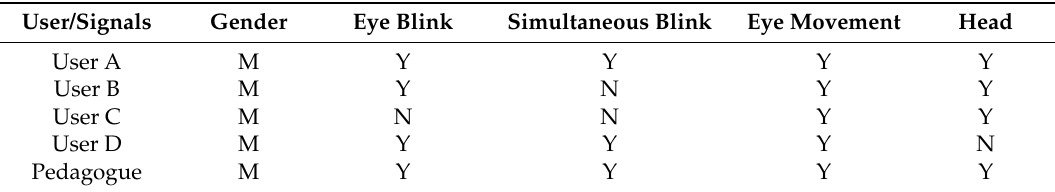
Table 1. Exploring the system.